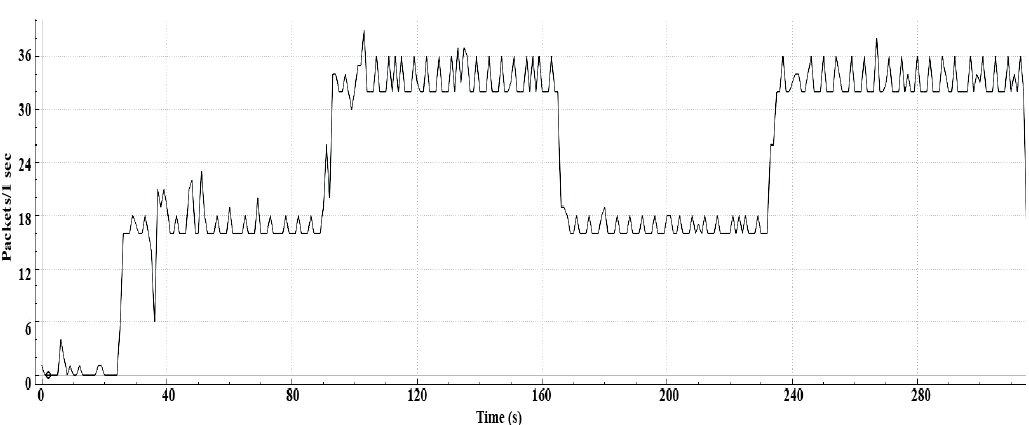
Figure 10. The graph includes the network traffic generated between two devices (M-DUINO and Arduino ONE) and the OPC UA server.